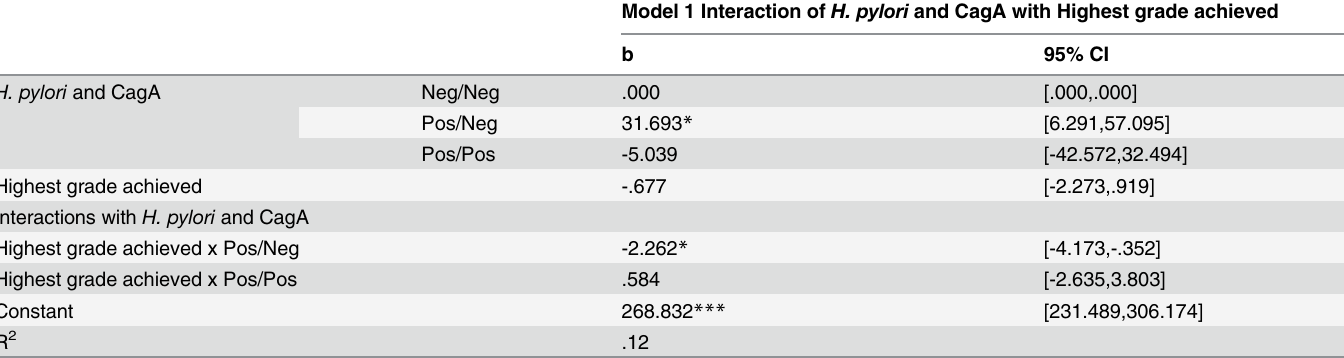
Table 6. Analysis of the Simple Reaction Time Test with Interactions of H. pylori and CagA in US 21 to 59 Year-Olds, NHANES III (1988 – 1994): Unstandardized Coef fi cients [95% CI] from Weighted OLS Regression. Model 1 Interaction of H. pylori and CagA with Highest grade achieved 95% CI